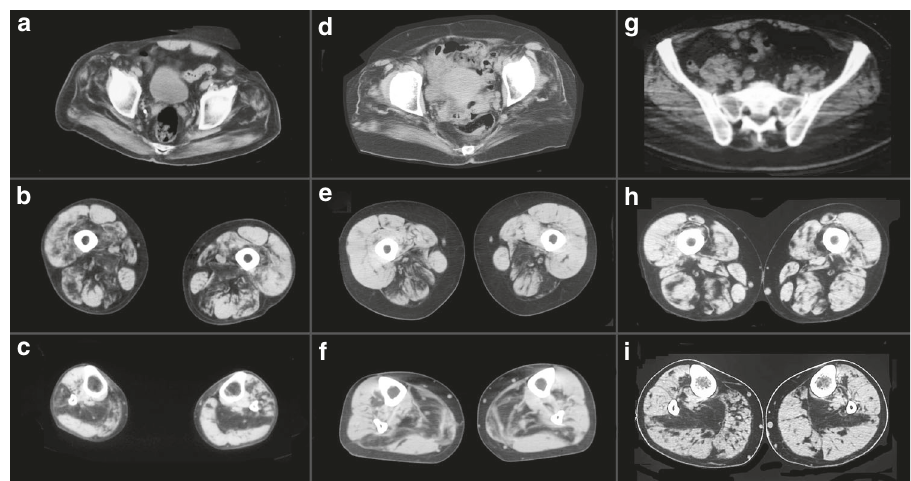
Fig. 2 Muscle imaging in myoglobinopathy. Muscle CT scan from individuals F1, II: 7 ( a – c ); F4, II: 4 ( d – f ); and F5, II: 6 ( g – i ) at the pelvic ( a , d and g ), mid- thigh ( b , e , and h ), and mid-leg ( c , f , and i ). At the pelvis, there is involvement of the gluteus maximus, medius, and minimus. At mid-thigh, there is preferential involvement of the posterior compartment, specially, of the adductor magnus, biceps femoris, and semimembranosus. At the mid-leg, the soleus is the fi rst and most-affected muscle